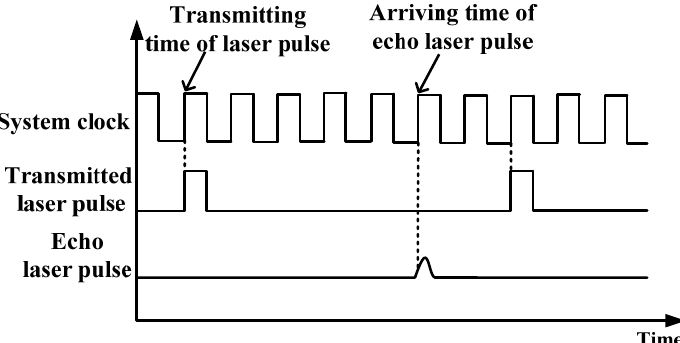
Figure 1. Schematic diagram of pulsed ToF laser ranging.